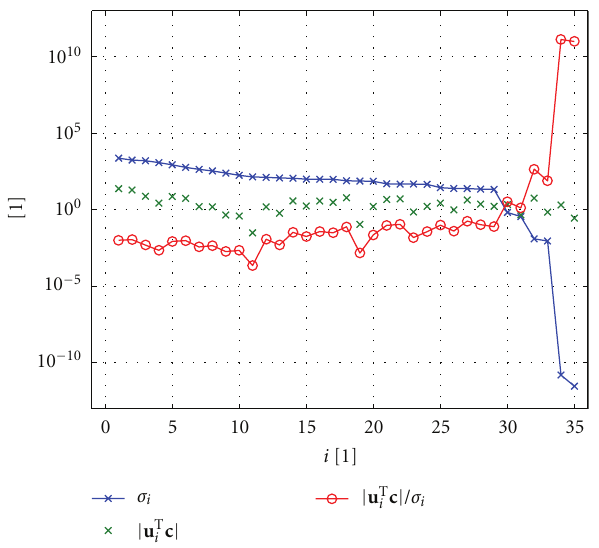
Figure 8: SVD analysis of the matrix A constructed from the example data shown in Figure 6. The plot displays the absolute values of the weighting factors ( u T i c ) /σ i and of their individual components | u T i c | and σ i on a logarithmic